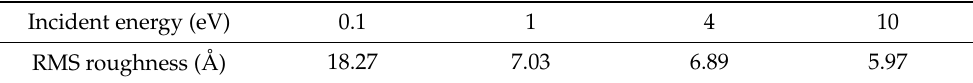
Table 1. R q of the film surface at different incident energies.